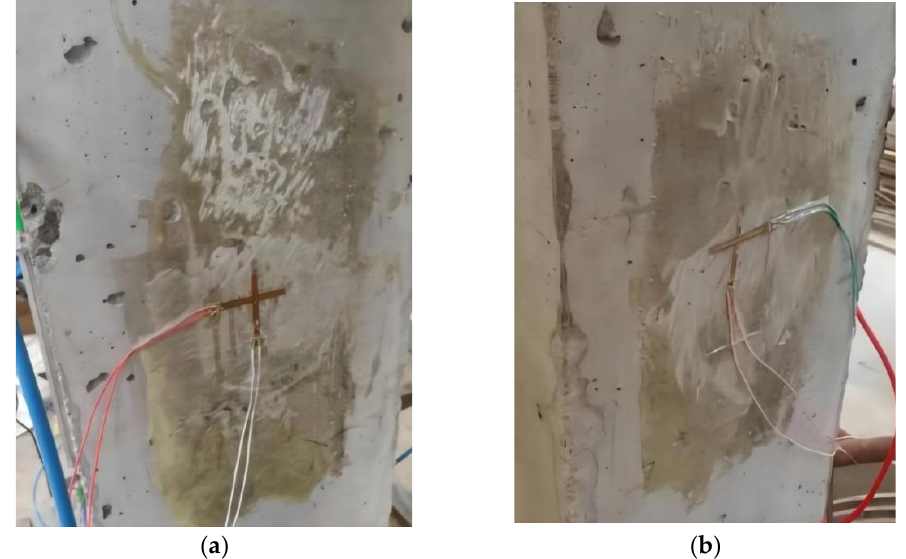
Figure 6. Installation diagram of resistance strain gauge: ( a ) left side and ( b ) right side.